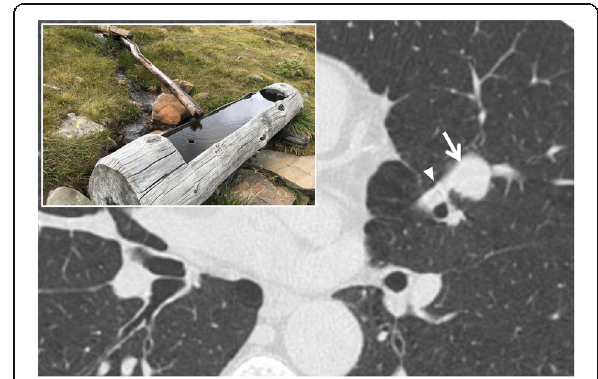
Fig. 12 Finger-in-glove sign. Axial CT scan of a patient with bronchocele — located in the right lower lobe (white arrows). A bronchocele consists of a pulmonary opacity with characteristic shape (linear, V or Y shape) — with well-defined lobulated margins: the appearance is similar to that of a